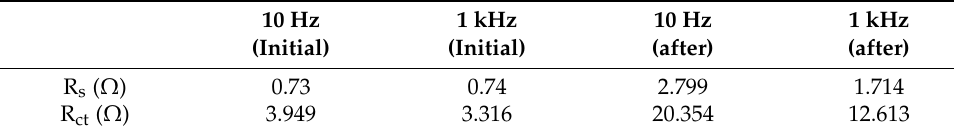
Table 2. Electrochemical parameters from the impedance